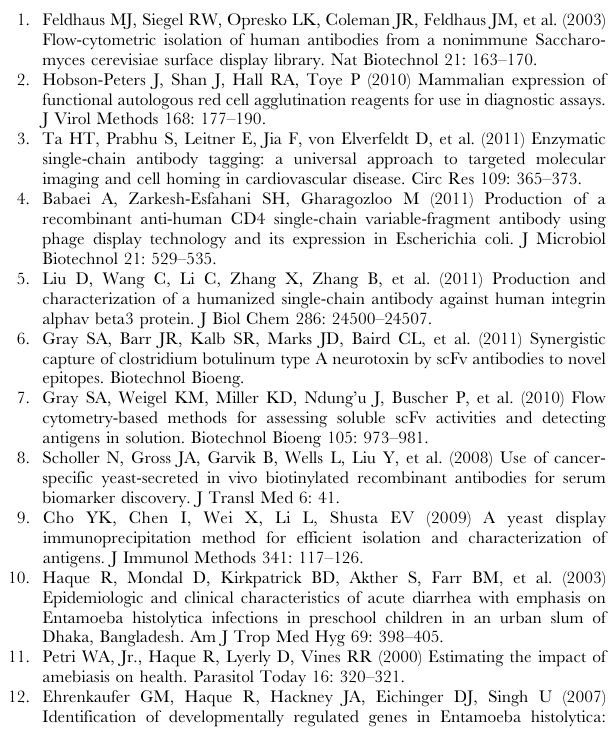
Figure S2 Lyophilization time course assay with yeast- scFv clone 350-12 . Three individual colonies of clone 350-12 were lyophilized separately on different days. Every 3 to 5 days, one aliquot of each was tested for binding to cognate antigen (100 nM 350-biotin) and to a non-cognate control antigen (100 nM 780-biotin) as described for Figure 5. The graph depicts the binding to the cognate or non-cognate antigens, as determined by percent of PE-positive yeast ( y -axis), for each of the time periods tested ( x -axis). Because of the staggered lyophilization dates, data were grouped into groups of 2 to 3 days, and each point represents the average and standard deviation for the day range indicated in the